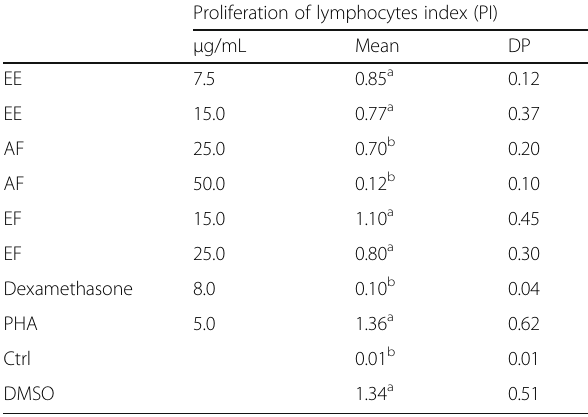
Table 3 Effect of EE extract and AF and EF fractions from stem bark of L . ochrophylla on the proliferation of activated lymphocytes for 5